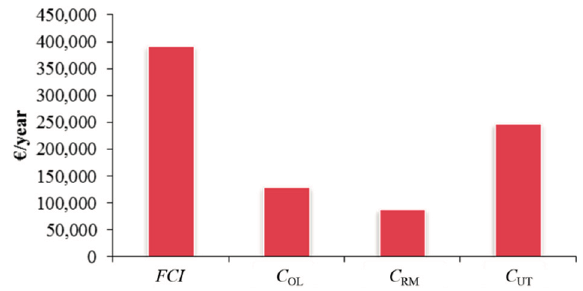
Figure 2. Distribution of costs in the extraction of maize stover